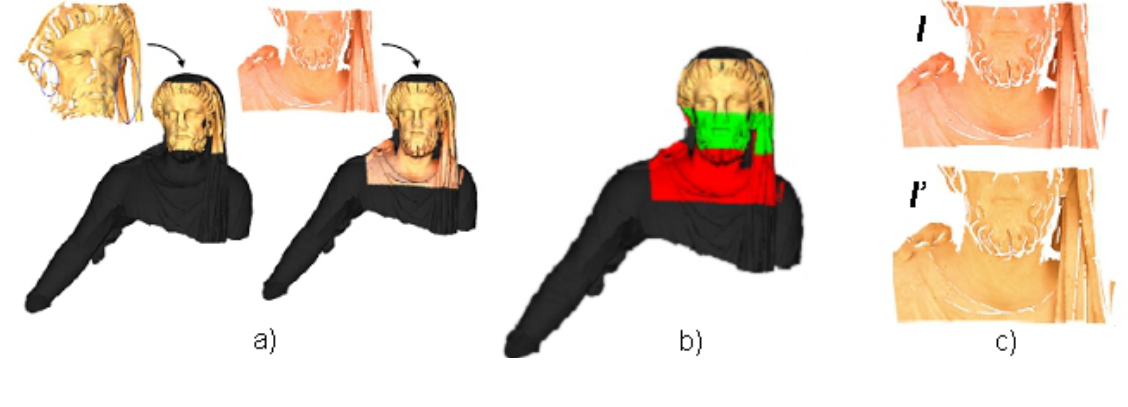
Figure 8. ( a ) Sequential procedure: Partial colour mapping superimposed onto the geometrical model. ( b ) The entire geometrical model with the intersection region in green. ( c ) The view to be merged before and after the initial